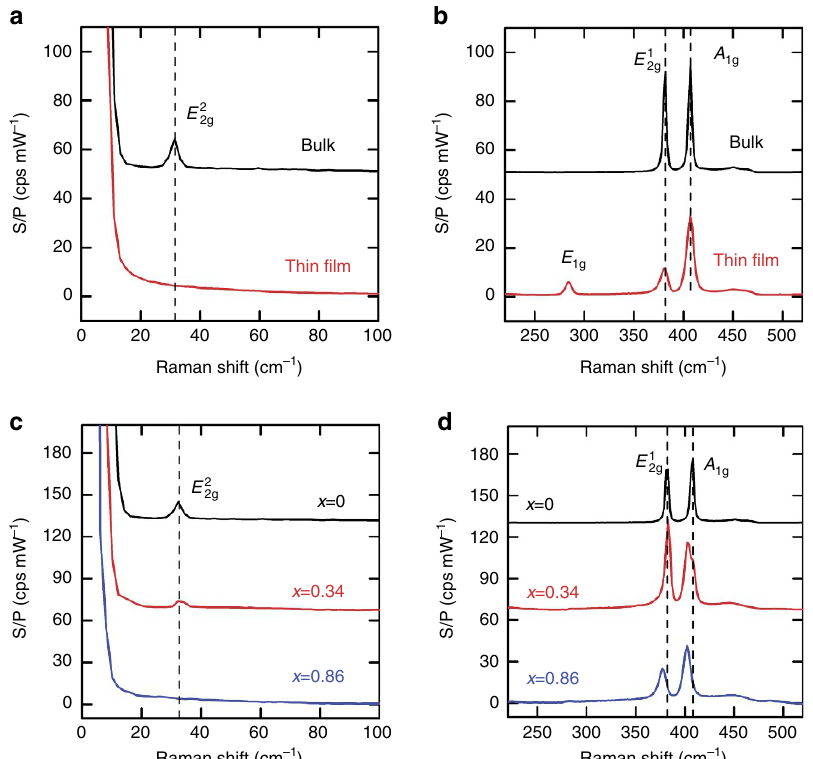
Figure 2 | Raman spectra for bulk and thin-film MoS 2 samples before lithiation. Spectra obtained at ( a ) low frequencies and ( b ) high frequencies. The y -axis is the signal intensity normalized by laser power (S/P) in the unit of counts per second per milliwatt (cpsmW (cid:2) 1 ). The bulk spectrum is shifted up by 50cpsmW (cid:2) 1 . Raman spectra for bulk Li x MoS 2 samples at different degrees of lithiation ( x ¼ 0, 0.34 and 0.68) at ( c ) low frequencies, ( d ) high frequencies. The x ¼ 0.34 and x ¼ 0 spectra are shifted up by 65 and 130cpsmW (cid:2) 1 , respectively.